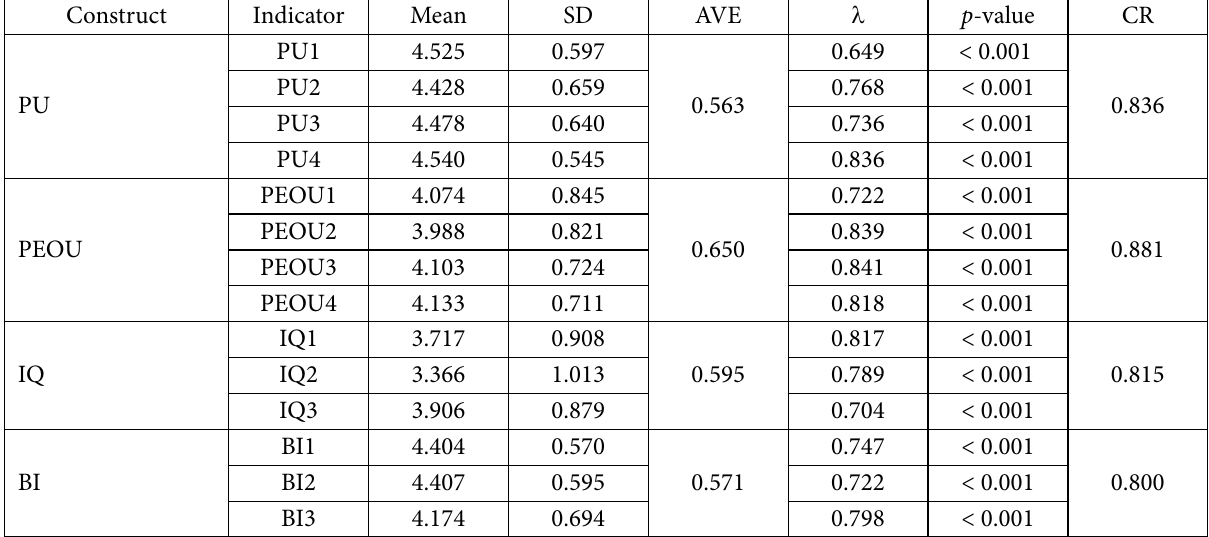
Table 6. Results of confirmatory factor